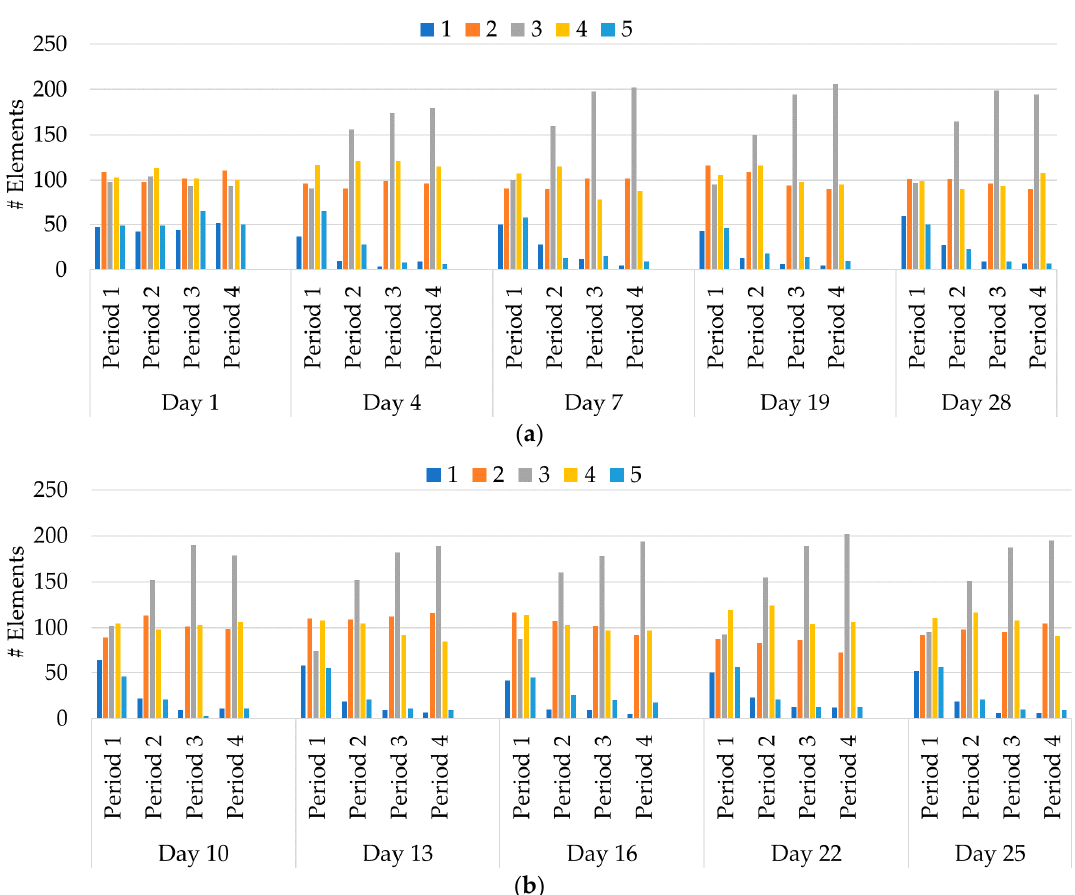
Figure 8. Number of elements per Reliability Rate group considering the initial rate being: ( a ) DR event 1; ( b ) DR event 2.